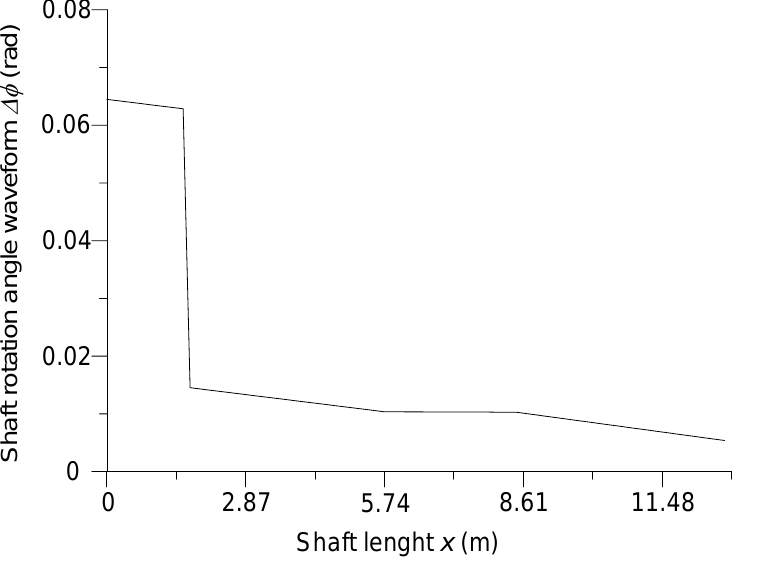
Figure 13. Angle of rotation of the long drive shaft as a function of the shaft length during a three-phase symmetrical short circuit for t = 15.1 s.